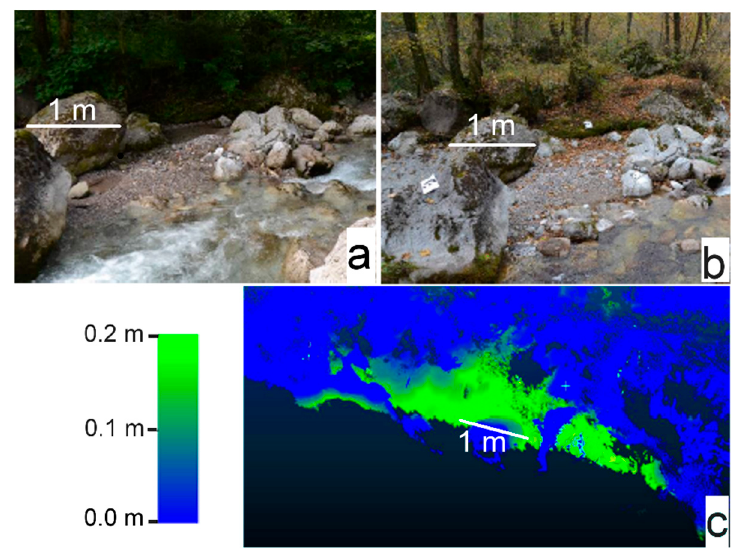
Figure 8. Upstream deposition area. ( a ) Picture taken in spring, 2016 and in ( b ) in fall, 2017; ( c ) Cloud-to-cloud comparison results; color range highlights the accumulation of debris (in green).